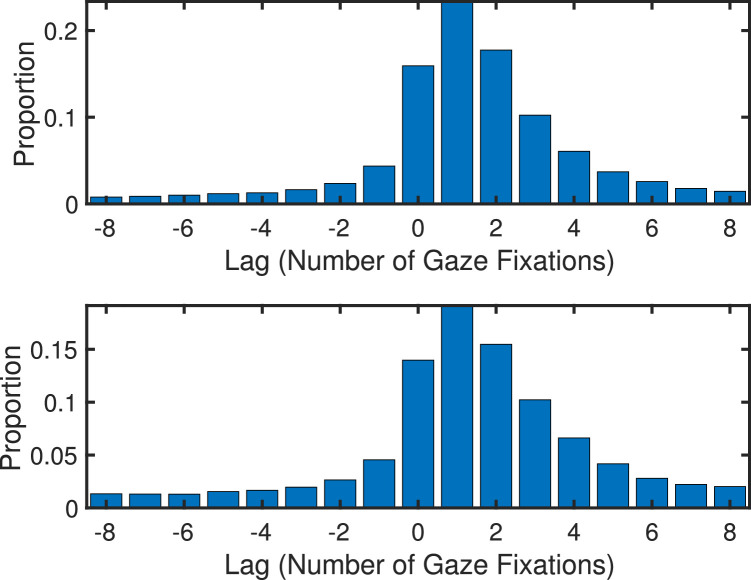
Histogram of gaze-head lags for landscape scenes (top) and fractal scenes (bottom), with the lag expressed in number of gaze fixations. If gaze is closer to a later head position, that is, has a positive lag, then gaze is leading. If gaze is closer to an earlier head position, that is, has a negative lag, then gaze is trailing. The results show that gaze is leading head in most cases, with a peak lag of about one to two fixations, corresponding to about 200 ms.